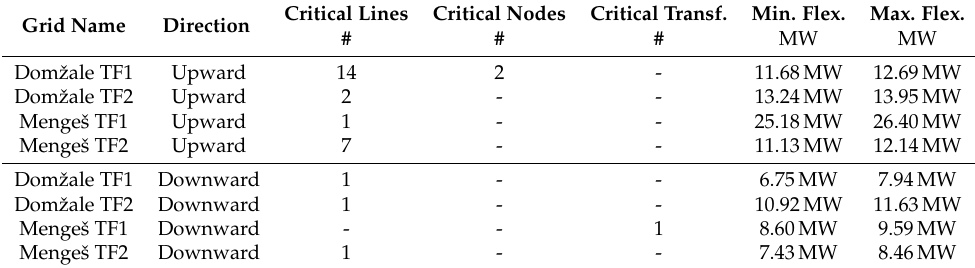
Table 13. Maximum activate-able flexibility in the Slovenian demo network for selected